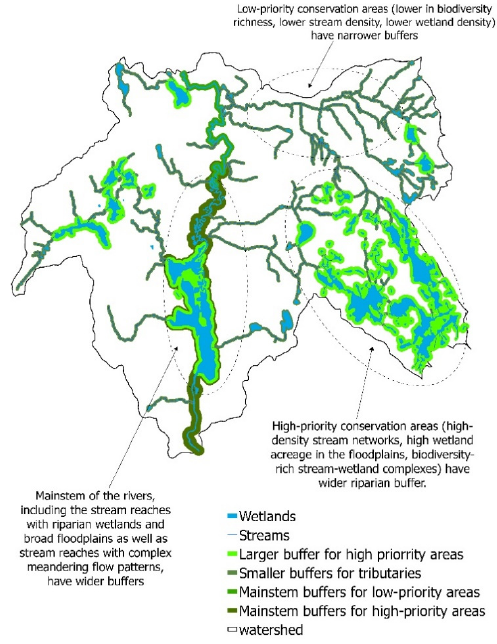
Figure 4. Variable buffer widths applied to stream channels (mainstem and tributaries) and stream- associated wetlands at the watershed scale. Increased riparian buffer widths are applied to regions with high conservation potential and other critical hydrological or ecological features to protect in- fertility ecosystem structure and functions.